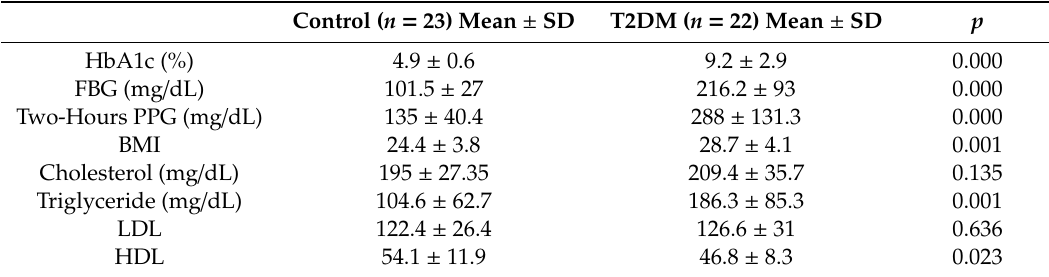
Table 1. Characteristics of Subjects.